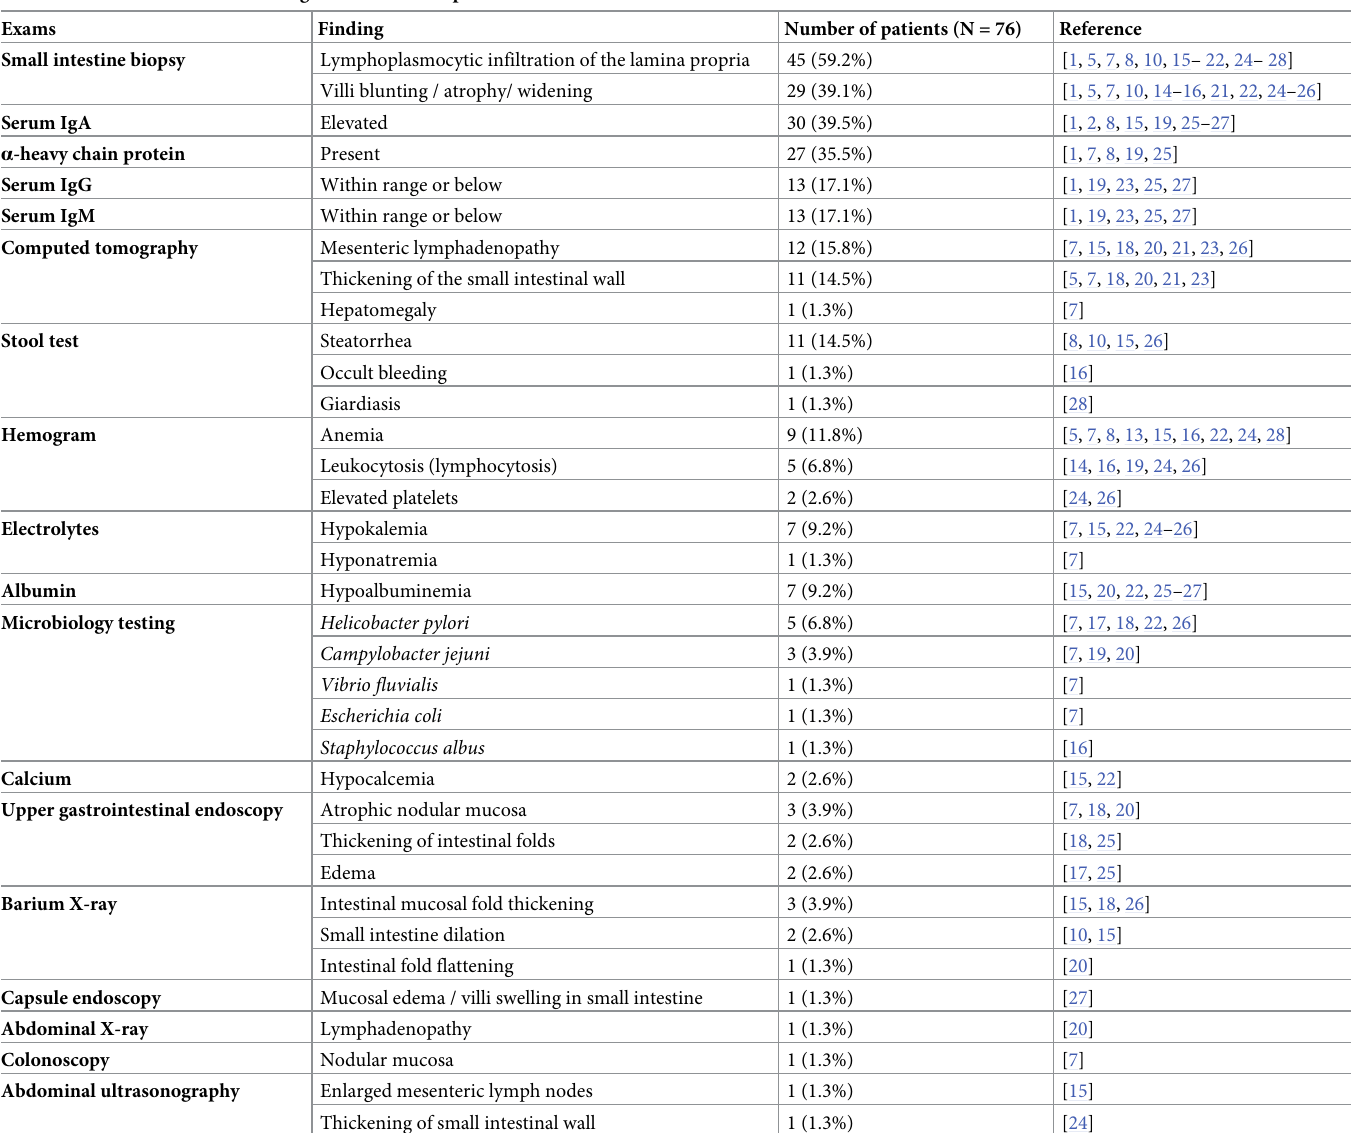
Table 3. Most common exam findings found in IPSID